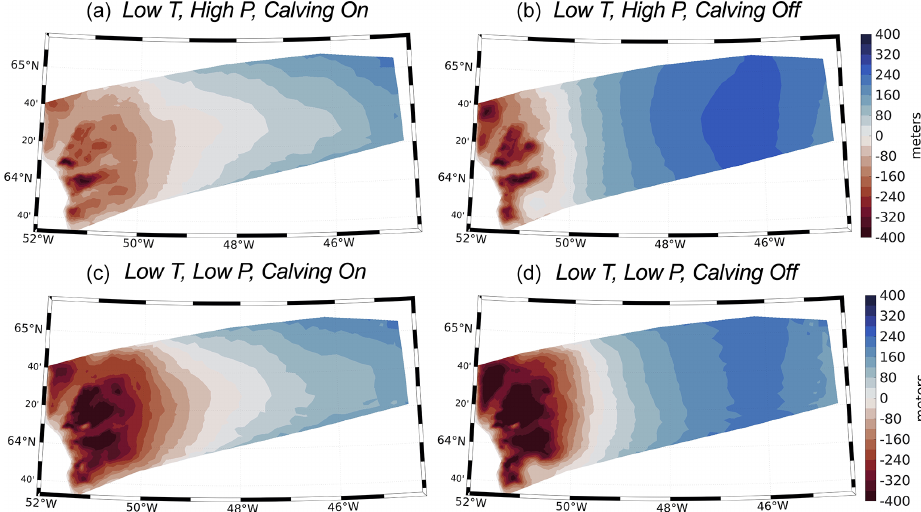
Figure 10. Simulated elevation changes during the period 12–10ka shown for experiments using the low-temperature